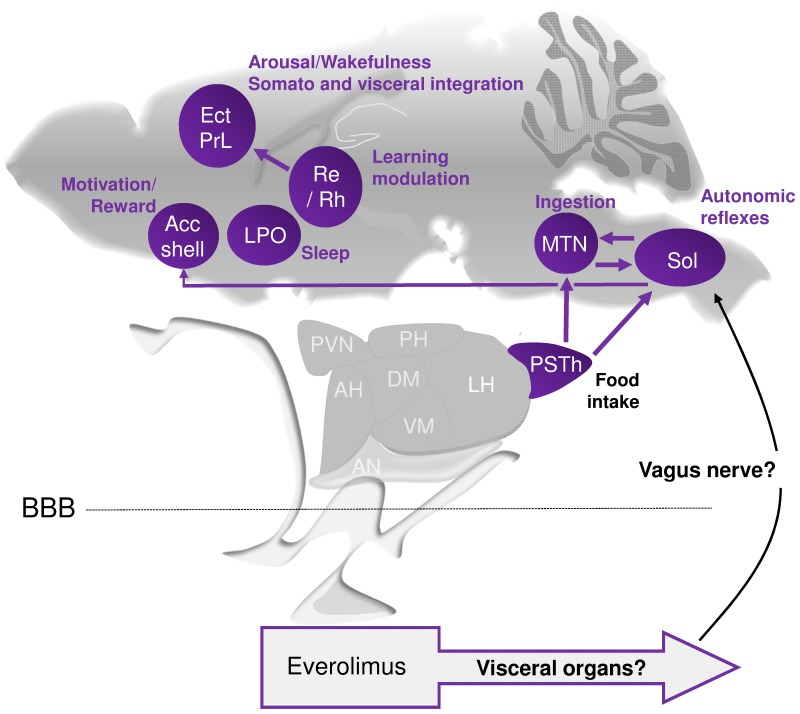
Schematic representation of brain areas presenting cytochrome oxidase activity modifications in mice treated with everolimus.Everolimus does not induce alteration of the phosphorylated P70S6K in the studied brain areas. It is here hypothesized that everolimus direct action on visceral organs would impact some cerebral areas through the vagus nerve. Among the brain areas with CO activity modifications are the solitary nucleus (Sol) as the principal recipient of visceral information conveyed by the vagus afferents and connected with the autonomic nervous system, motor nuclei of cranial nerves, nuclei in the brainstem and hypothalamus; the parasubthalamic nucleus (PSTh) within the hypothalamus, and motor trigeminal nucleus (MTN) involved in ingestion; the accumbens (Acc) shell important for reward and motivation processes; the preoptic area (LPO) regulating sleep/wake state; and the thalamic reuniens (Re) and rhomboid (Rh) nuclei and cortical areas that integrate arousal, somatosensory and visceral information, and participate to the modulation of learning and memory, and maintenance of arousal and wakefulness. Thus brain areas with modified CO activity are involved in the integration of autonomic and neuroendocrine information important for regulation of food intake, weight, metabolic, motivational processes, and arousal, that could be associated with symptoms suggestive of fatigue and energy homeostasis alterations. Arrows in purple show connections between brain areas metabolically modified. AH, anterior hypothalamic area; BBB, brain blood barrier; DM, dorsomedial hypothalamic nucleus; Ect, ectorhinal cortex; LH, lateral hypothalamic area; PH, posterior hypothalamic nucleus; PrL, prelimbic cortex; PVN, paraventricular hypothalamic nucleus; VM, ventromedial hypothalamic nucleus.